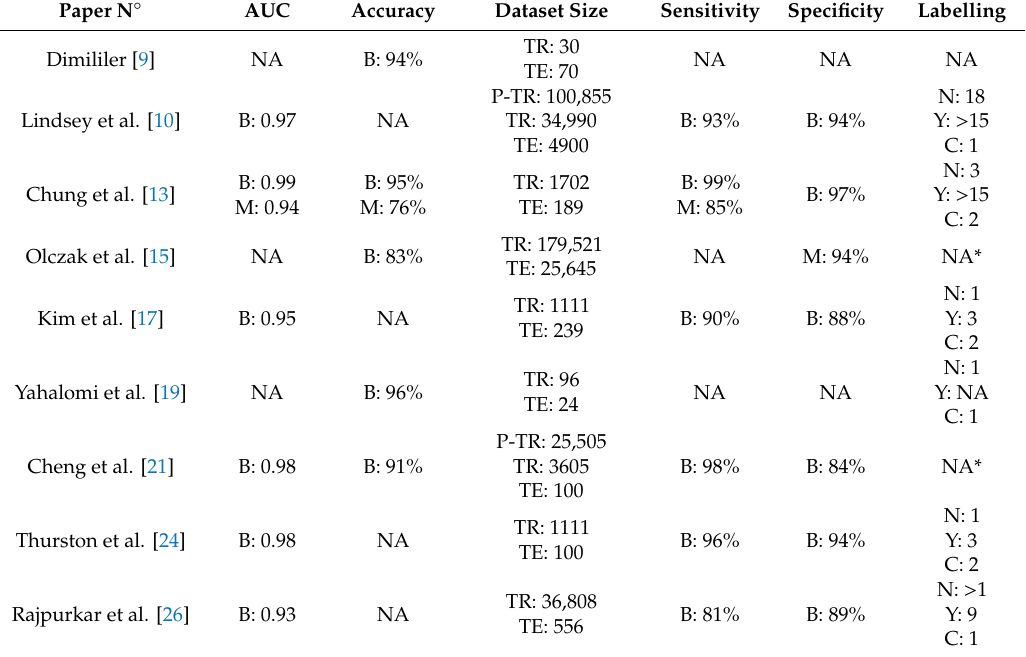
Table 1. Summary of the six di ff erent features of fracture classification methods, related to the corresponding paper. Legend: not assessable (NA); pre-training (P-TR); training (TR); testing (TE); binary (B); multi-class (M); number of specialists (N); average years of expertise (Y); number of subsequent checks